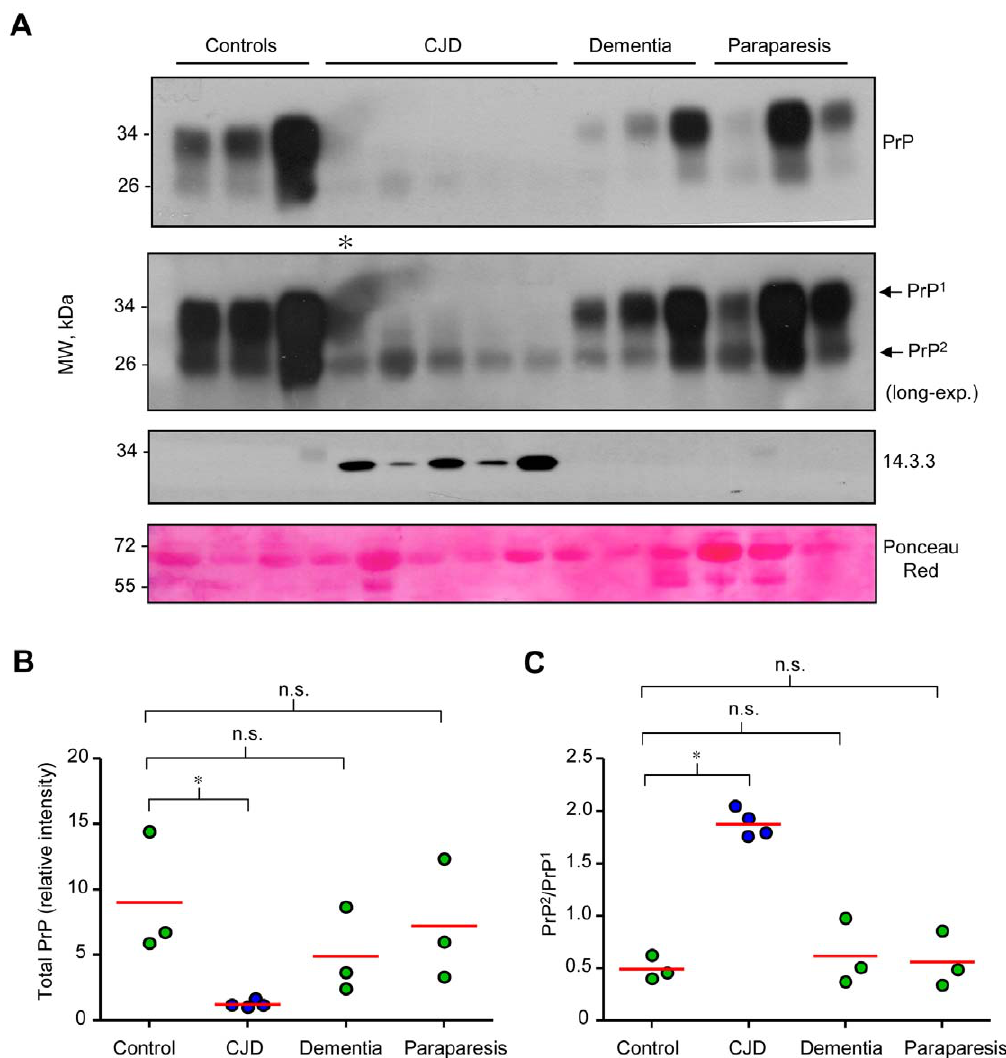
Figure 3. Alterations in PrP expression pattern in CSF are specific to CJD patients. CSF samples from healthy control subjects (N=3), CJD patients (N=5), dementia patients (N=3) and paraparesis patients (N=3), were obtained by lumbar puncture. A. Assessment of PrP levels (two upper panels with different exposure), and 14-3-3 protein levels (third panel) by Western blot analysis, and total protein content by Ponceau Red staining (lower panel, a selected band is presented). B. and C. Quantification of relative total PrP protein levels in CSF and the ratio of the PrP band 1 (upper) and PrP band 2 (lower) in CSF, respectively. The asterisk in A indicates one sample with a technical problem in the blot detection that was excluded for quantification of panel B and C. In B and C the red line represents the mean of all samples analyzed. Statistical significance was calculated using Student’s t-test.